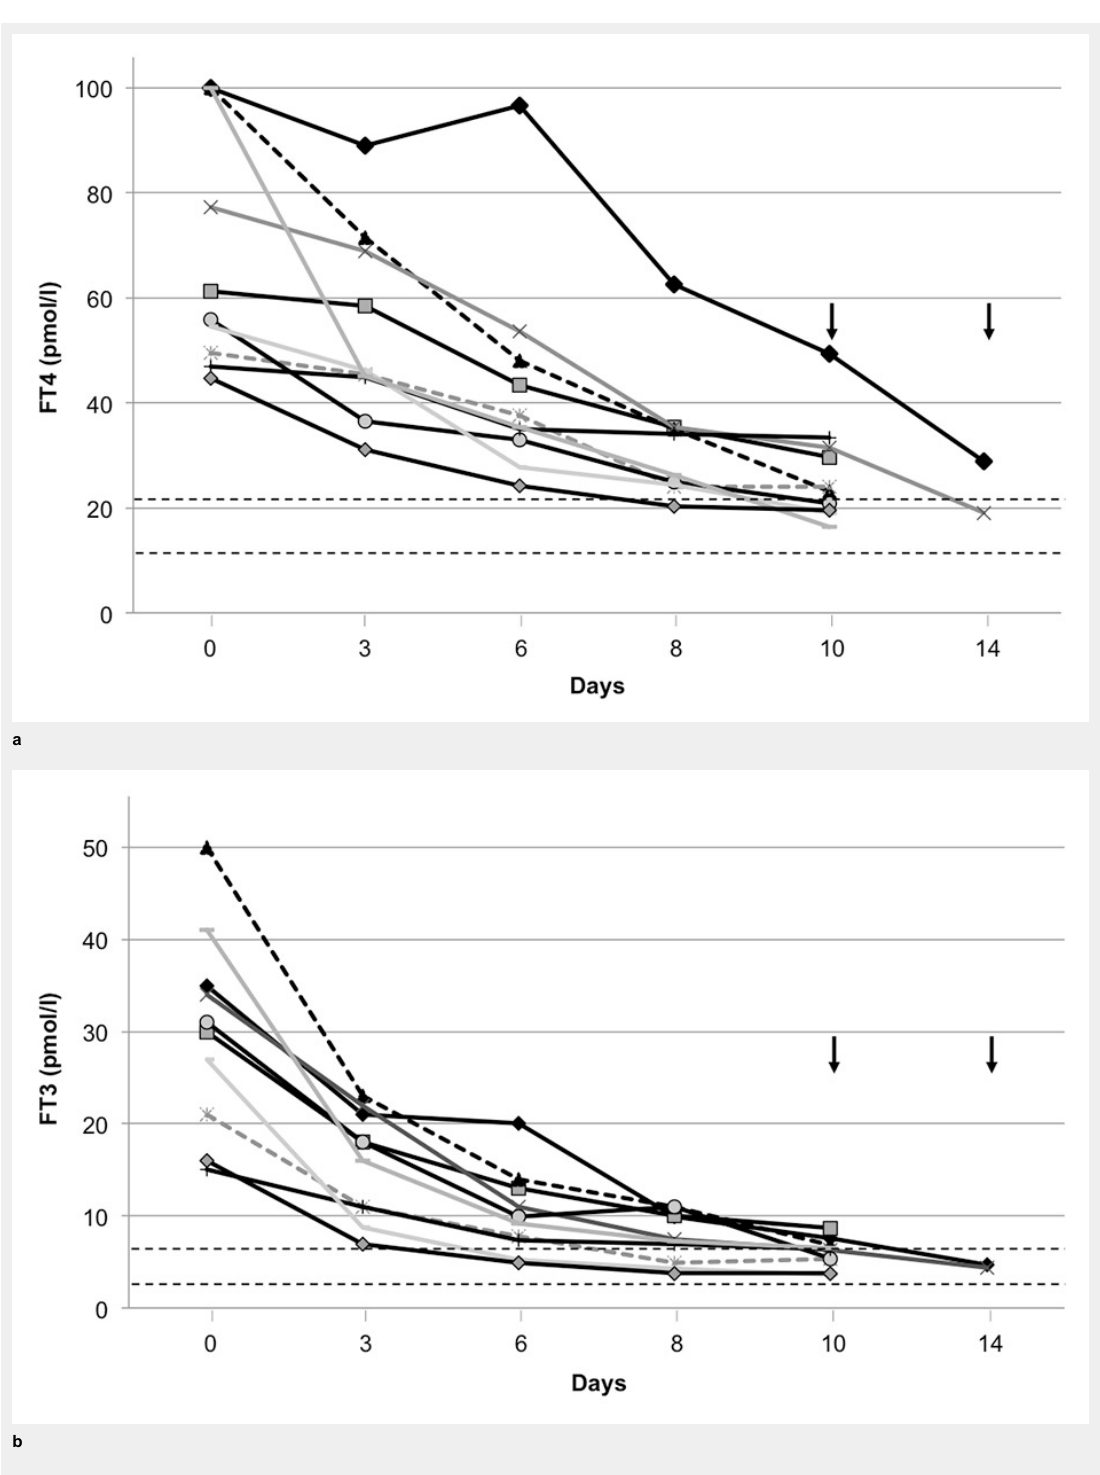
Figure 1 Serum concentrations of fT4 (1a) and fT3 (1b) in patients (n = 10) with Graves’ disease before and during treatment with a rapid preoperative hormone blocking protocol. Horizontal dashed lines indicate reference ranges, and the arrows denote time of surgery on day 10 (n = 8) and day 14 (n =